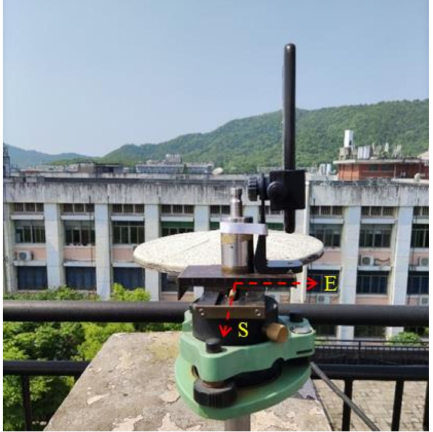
Figure 14. Experimental setup for simulated dynamic deformation